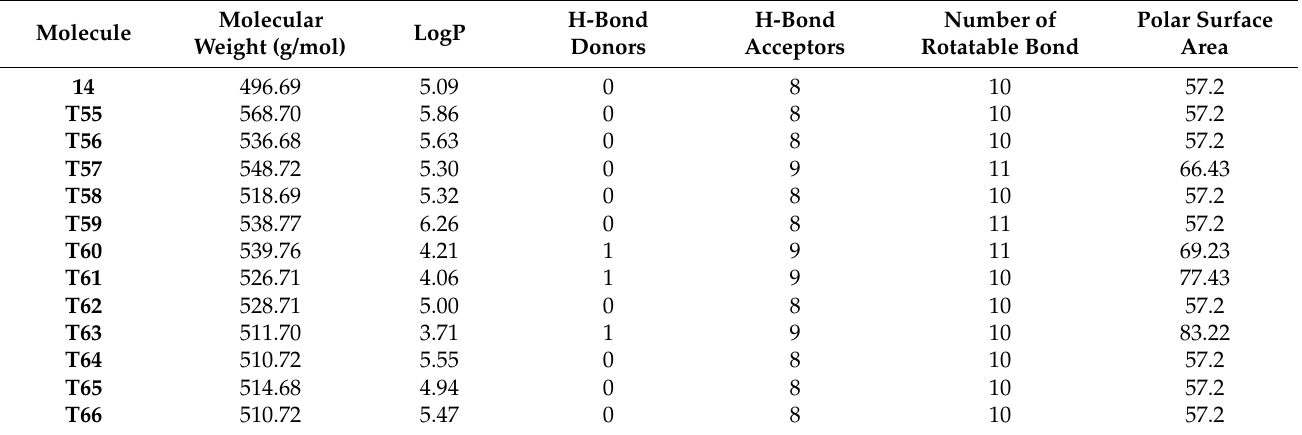
Table 7. Drug-likeness properties of newly designed inhibitors and the most potent template